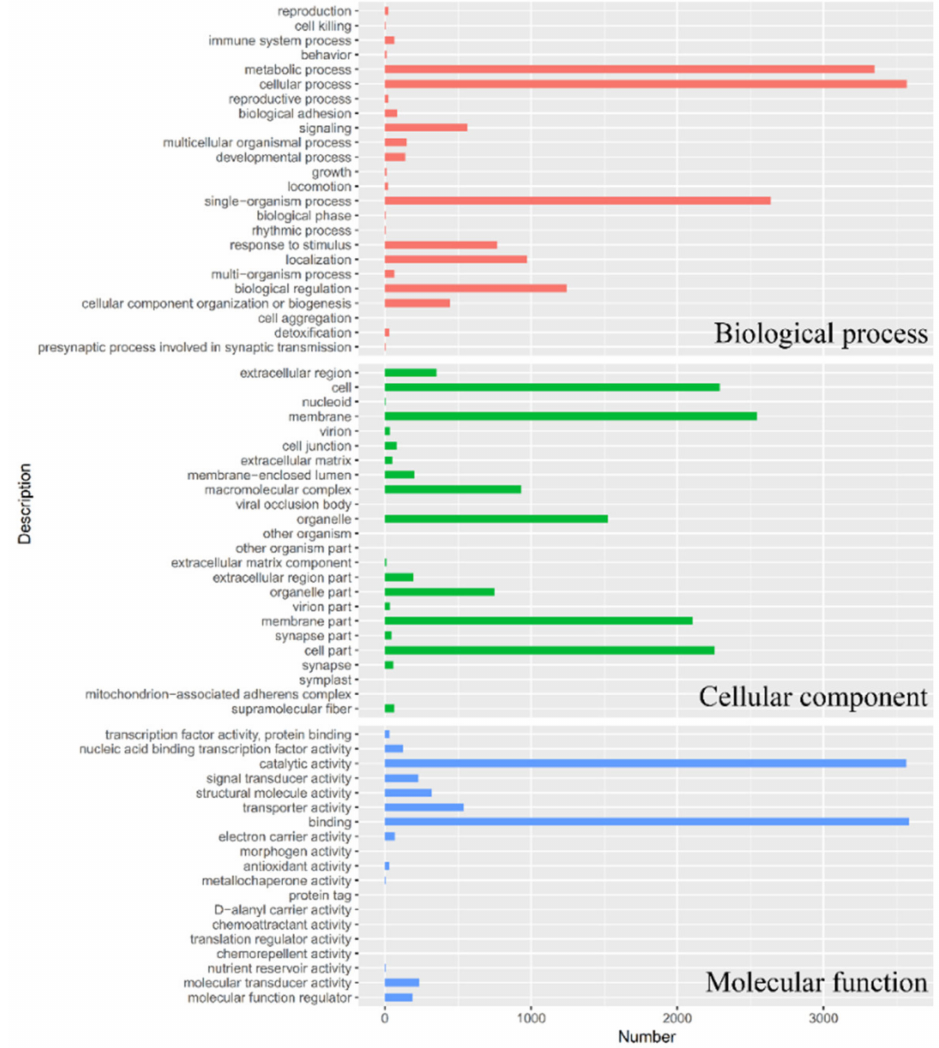
Figure 2. Gene Ontology (GO) classification analysis. Numbers of matched unigenes were plot- ted against each category for three main categories: biological process, cellular component, and molecular